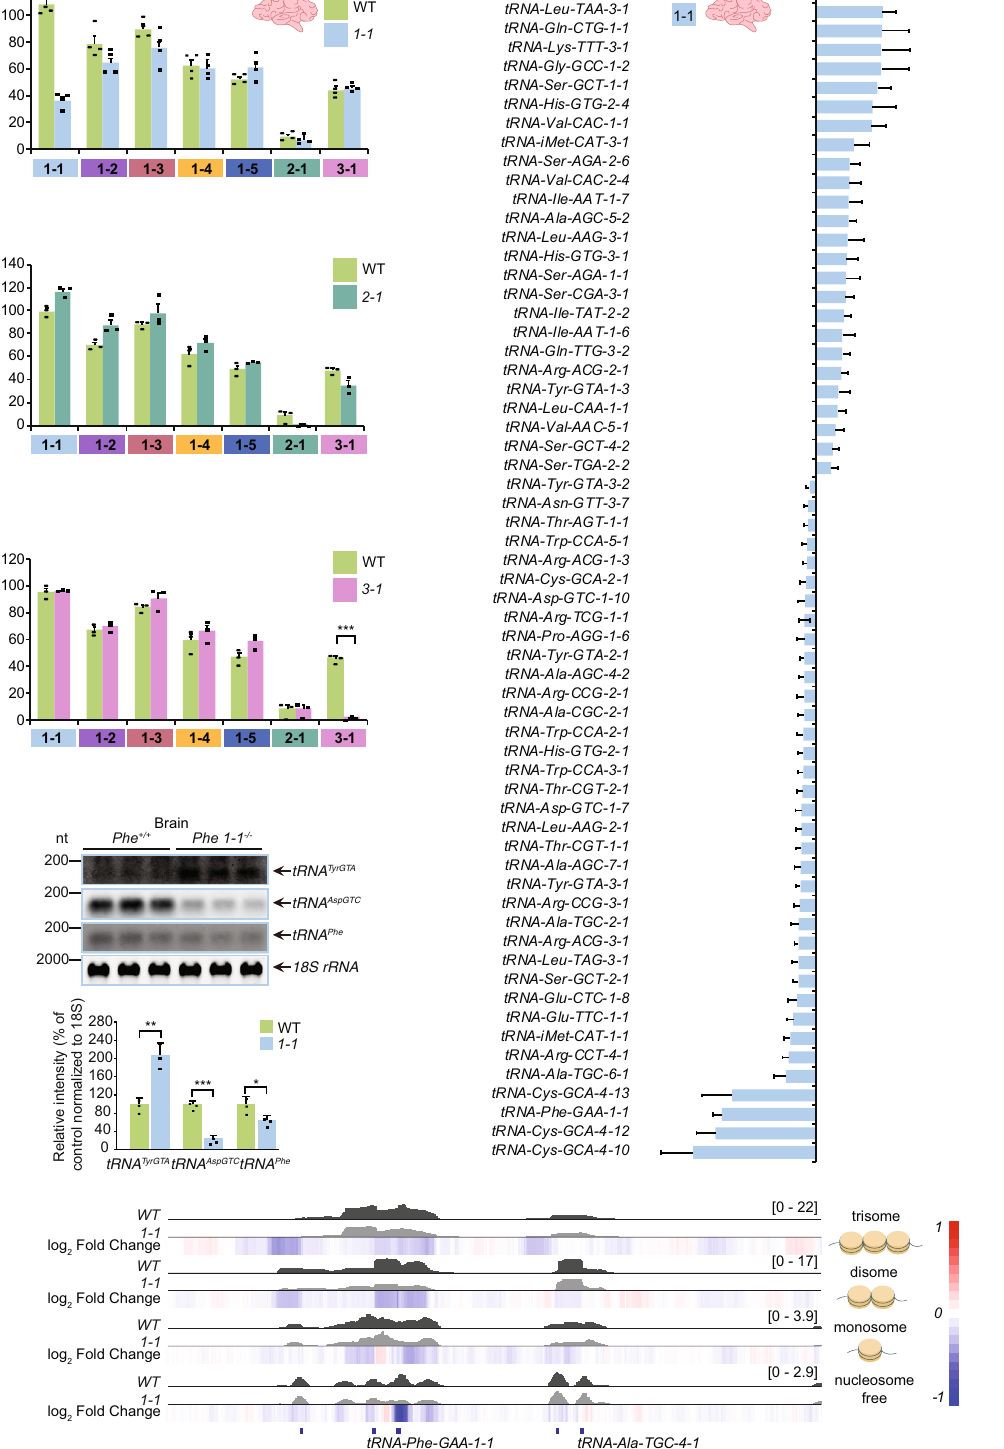
that the tRNA-Phe-1-1 gene is the mostcritical tRNA-Phe family member for development and survival. Discussion Genome-wide analyses of the consequences of mammalian multigene tRNA losses or mutations in vivo have not been explored